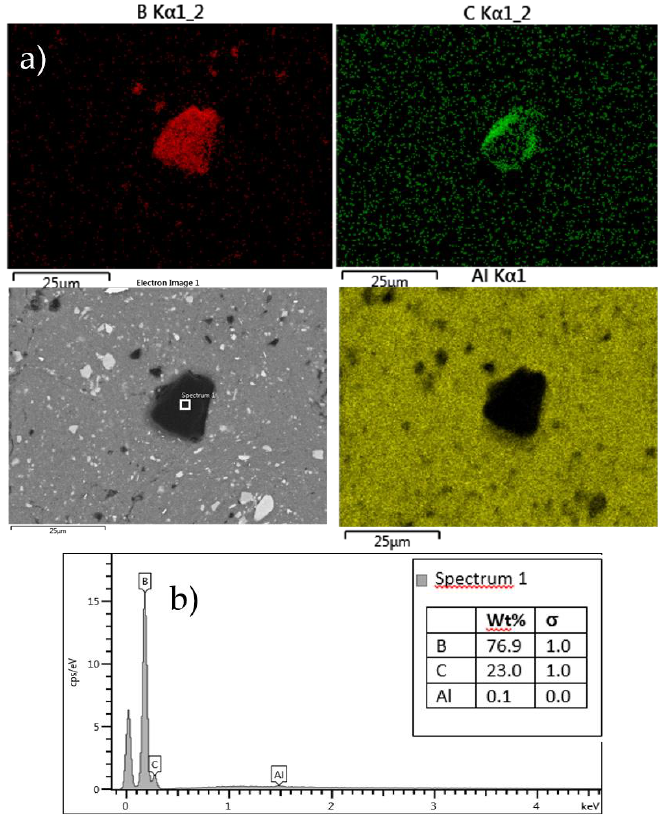
Figure 5. ( a ) scanning electron microscope-energy dispersive spectroscopy (SEM-EDS) mapping analysis of the Al2024-2.0 wt.% B 4 C milled for 2 h; ( b ) EDS analysis of a B 4 C particle.